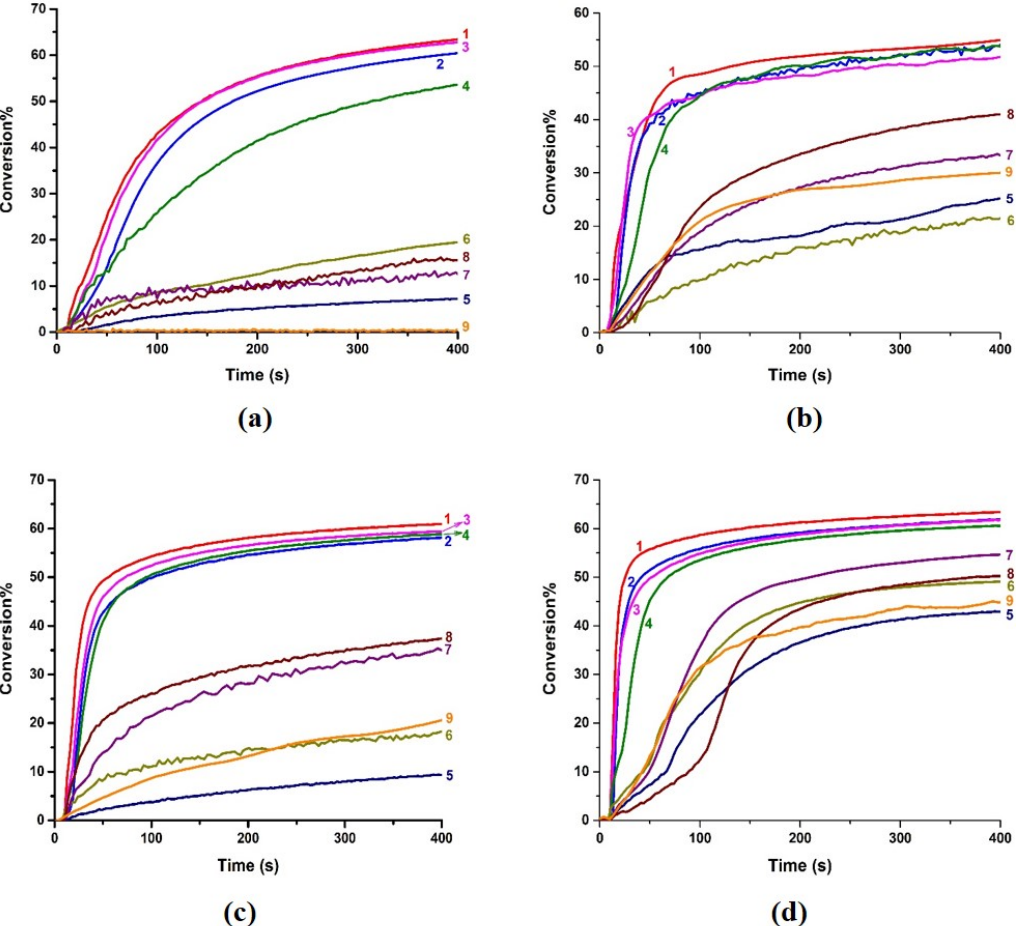
Figure 4. Photopolymerization profiles of TMPTA (acrylate function conversion vs. irradiation time) in laminate upon LED@365 nm irradiation in the presence of ( a ) PI alone (1.5%, w), ( b ) PI / EDB (0.5% / 1%, w / w ), ( c ) PI / Iod (0.5% / 1%, w / w ), ( d ) PI / EDB / Iod (0.5% / 1% / 1%, w / w / w ). (curve 1—BPC1-based PISs, curve 2—BPC2-based PISs, curve 3—BPC3-based PISs, curve 4—BPC4-based PISs, curve 5—C5-based PISs, curve 6—C6-based PISs, curve 7—C7-based PISs, curve 8—C8-based PISs, curve 9—BP-based PISs); the irradiation starts from t = 10